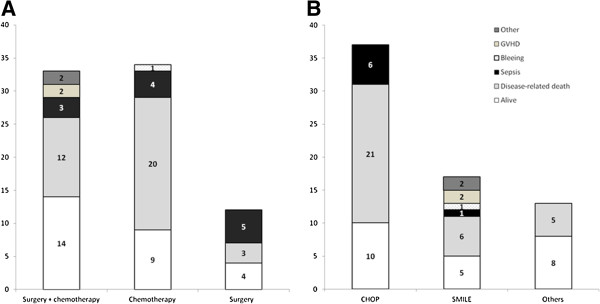
Comparison of treatment outcomes based on treatment modality and chemotherapy regimen. (A) Treatment outcomes for patients treated with chemotherapy or surgery or both. (B) There is no significant difference of death causes according to the type of chemotherapy regimens.